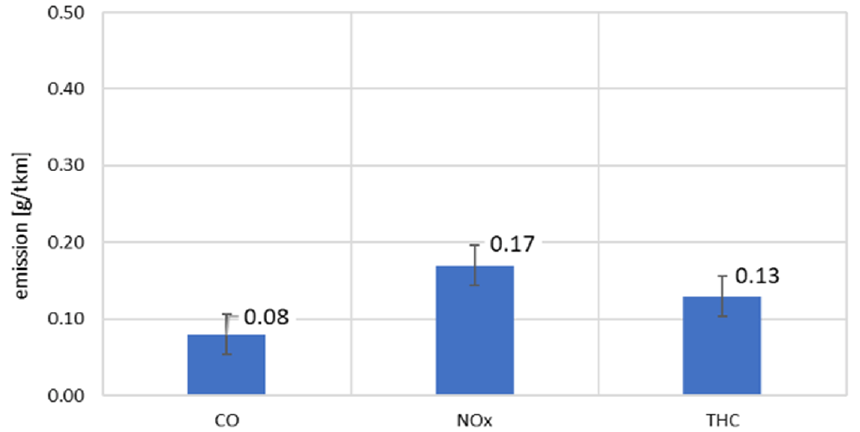
Figure 8. Emission referred to the transport operation of the tested tractor-trailer. In the case of a forklift, greater emission indexes of NO x and THC were recorded for the test runs performed inside the warehouse. It reached a value greater by 8% and 35% respectively compared to the values of the same obtained during the outdoor test runs. An opposite trend was observed for carbon monoxide whose emission per ton-kilometer was over 8% higher when measured in the outdoor test (Figure 9). The emission of CO 2 in both cases was similar and amounted to over 3 g/tkm.